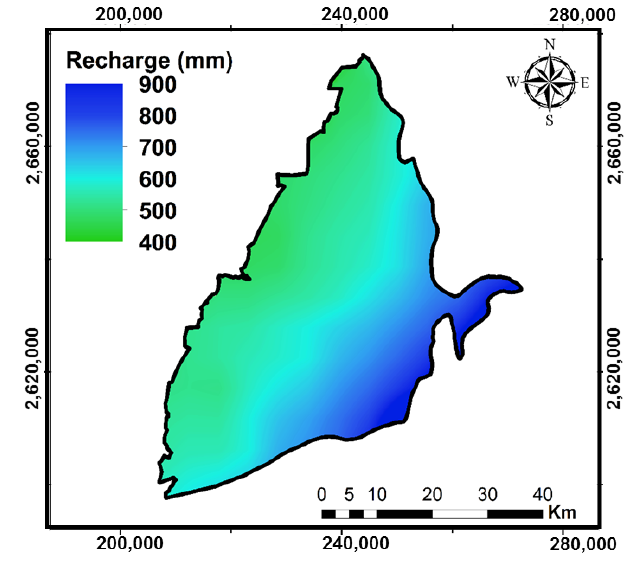
Figure 7. The annual average of groundwater recharge from 2006 to 2015.